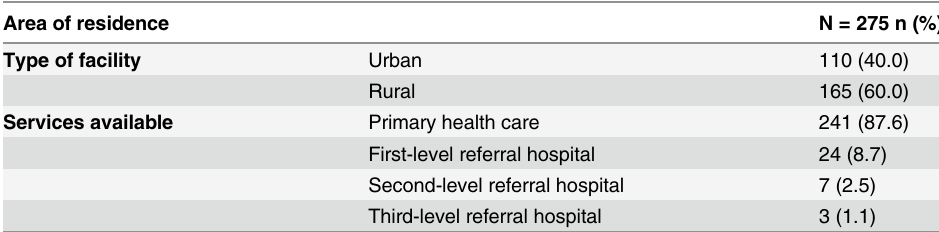
Table 2. Characteristics of the 275 health